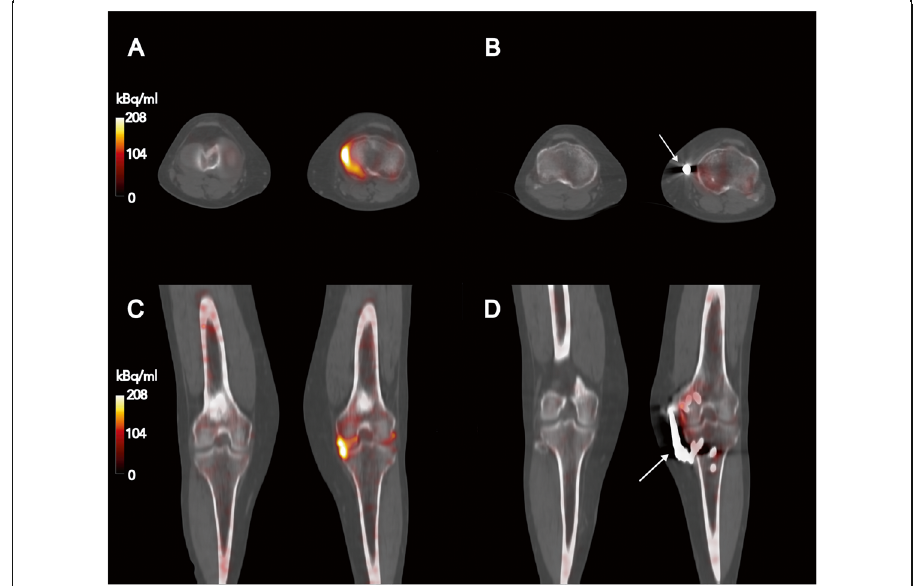
Fig. 1 a , c Pre-OP SPECT-CT images from a patient (f, 46 year, SPECT-CT: 5 months pre-implantation) with beginning knee OA and b , d corresponding post-op imaging (14 months post-implantation) exemplifying the effect from the examined load absorber ( b , d : metal artifact labeled by arrow). Patient showing a significant decrease in bone turnover after implantation at the level of the left tibia plateau (AC max, pre = 309.2 kBq/ml, [SUV max = 77.5] and AC max, post = 99.0 kBq/ml, [SUV max = 31.7]). Accumulation patterns from bone turnover (pre/post) were windowed